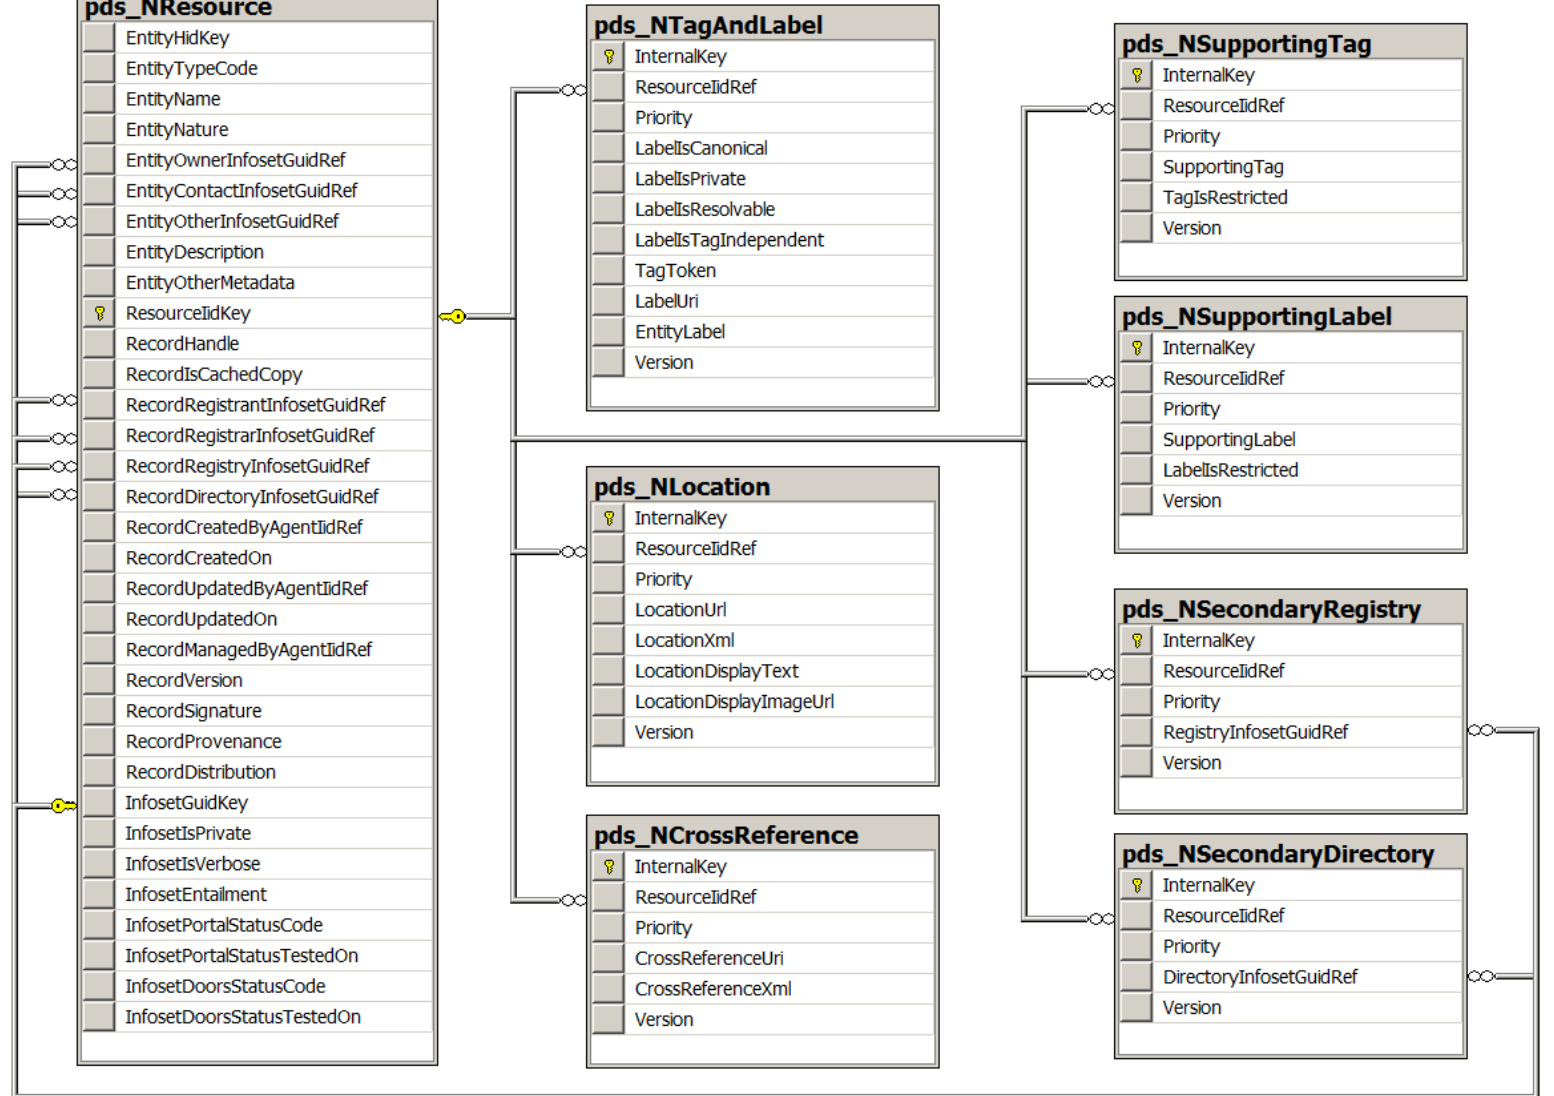
Figure 5. Relational database model for NEXUS combined design server with integrated storage of both PORTAL and DOORS data record fields as a NEXUS data record. See Figure 6 for the administrative content of a NEXUS